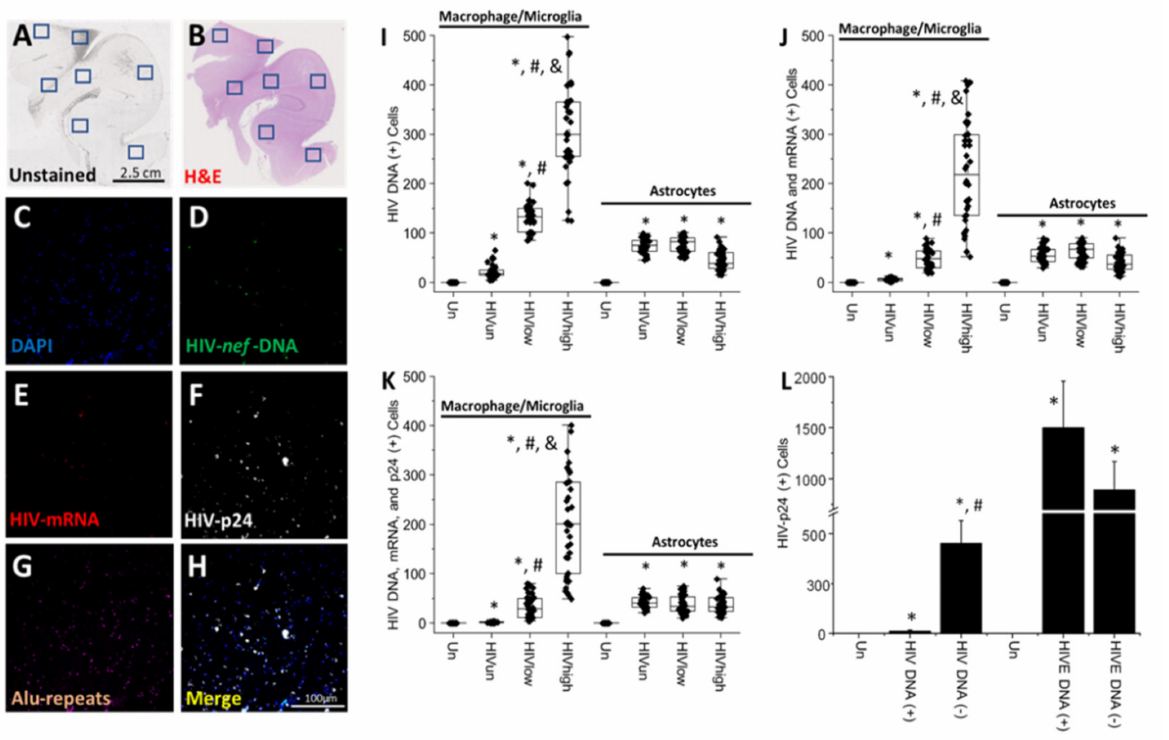
Figure 2. Quantification of myeloid and glial viral reservoirs in cortical and subcortical human brain areas. Representative confocal images of the areas analyzed for ( A ) unstained and ( B ) H&E- stained tissue. Areas detected with HIV DNA are represented in blue boxes. ( C – H ) Representative confocal images of the brain areas containing integrated HIV DNA and positive labeling for ( C ) DAPI, ( D ) HIV DNA, ( E ) HIV-mRNA, ( F ) HIV-p24, ( G ) Alu repeats, and ( H ) the merge of all colors. ( I – K ) Quantification of cells positive for ( I ) integrated HIV DNA in Macrophage/Microglia (Iba-1- positive cells) and astrocytes (GFAP-positive cells) in human tissues obtained from individuals